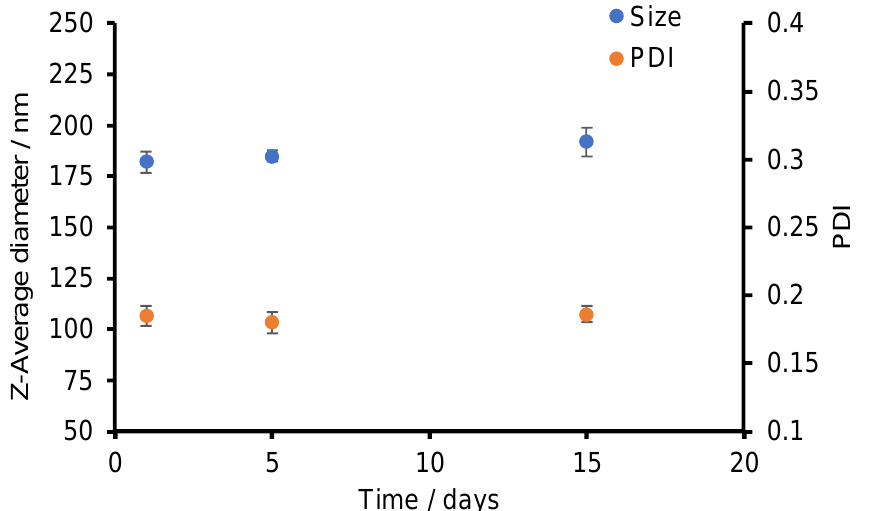
Figure 3. The evolution of size and PDI of 1:1 PTX-CUR NPs over a period of 15 days. PTX and CUR stand for paclitaxel and curcumin.